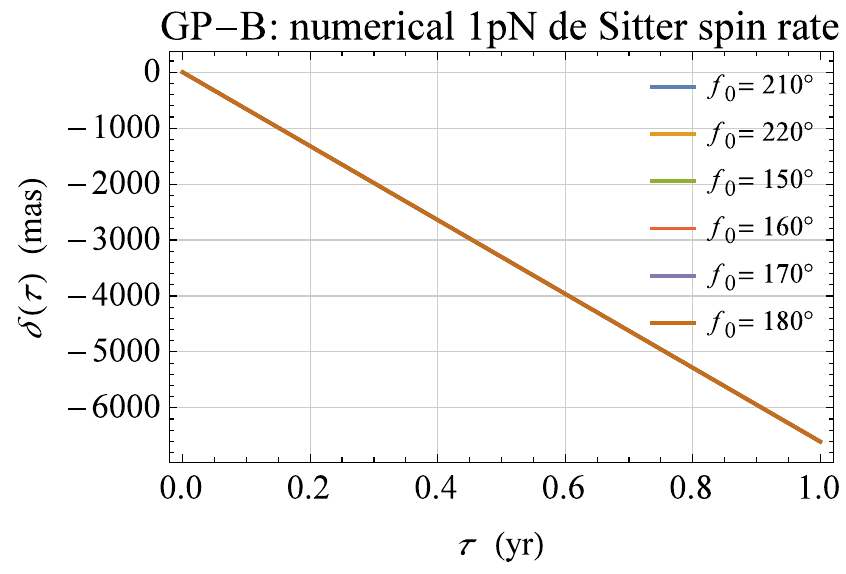
Figure 1. Numerically produced 1pN de Sitter time series δ ( τ ) , in mas, of the declination δ of the spin axis of a gyroscope orbiting the Earth along a Keplerian ellipse for some different initial values of the true anomaly f 0 . Each of the times series was obtained by simultaneously integrating Equations (1) and (4) with J 2 = 0 in Equations (5)–(9), and calculating arcsin S z ( τ ) for the resulting solution S z ( τ ) of each run. It turned out that essentially the same outcome can also be obtained by replacing Equation(4) with the 3-dimensional Newtonian acceleration A N = − the gyroscope. The initial conditions adopted, common to all of the integrations, were those of GP-B [25], summarized in Table 1. All the shifts are independent of f 0 , and their slopes amount just to ˙ δ = − 6603.8masyr − 1 , as dS